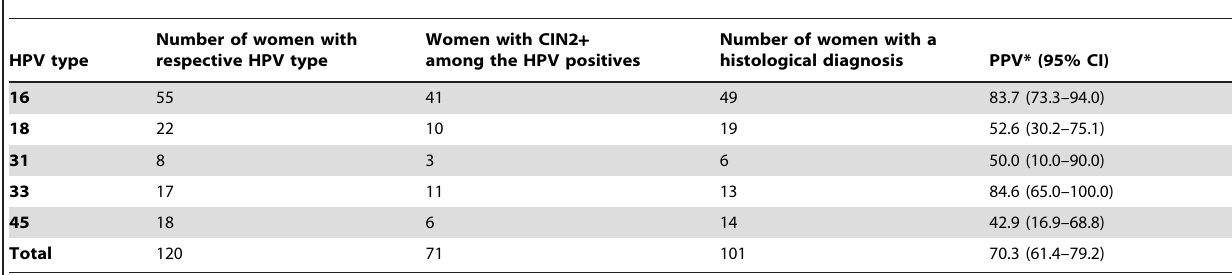
Table 3. PPV for CIN2 + for the different HPV-types, including women . 40 years of age.